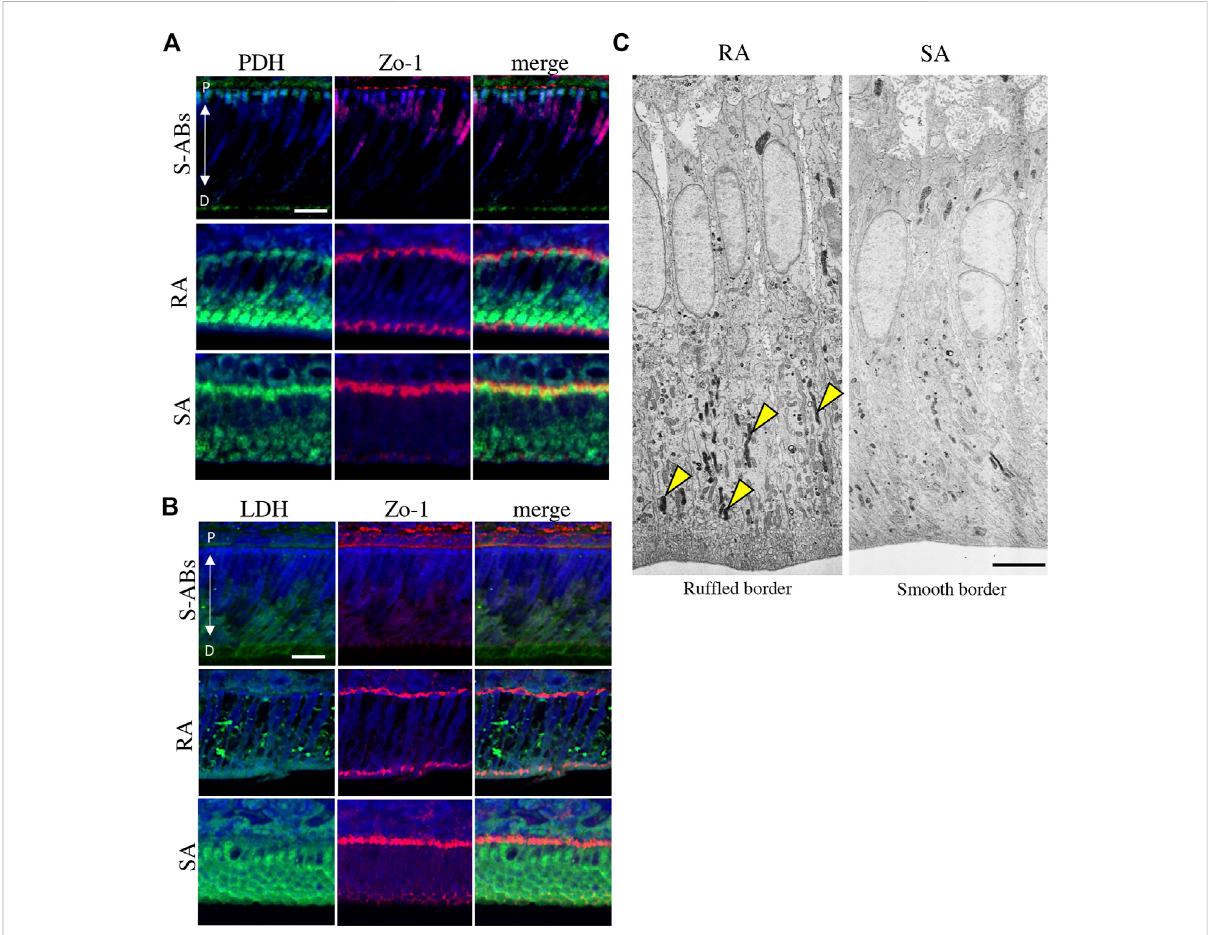
FIGURE 2 Energy metabolic state during ameloblasts differentiation in vivo . Double immunostaining for Zo-1 and PDH (A) and LDH (B) in P10 mouse maxillaryincisors.NucleiwerestainedwithDAPI(blue). (C) Electronmicroscopicimagesofcytochromeoxidase(CO)activityinratruf fl e-ended(left) and smooth-ended (right) ameloblasts. Arrowheads indicate CO-positive mitochondria. Scale bars:20 µm (A,B) and 5 µm (C)